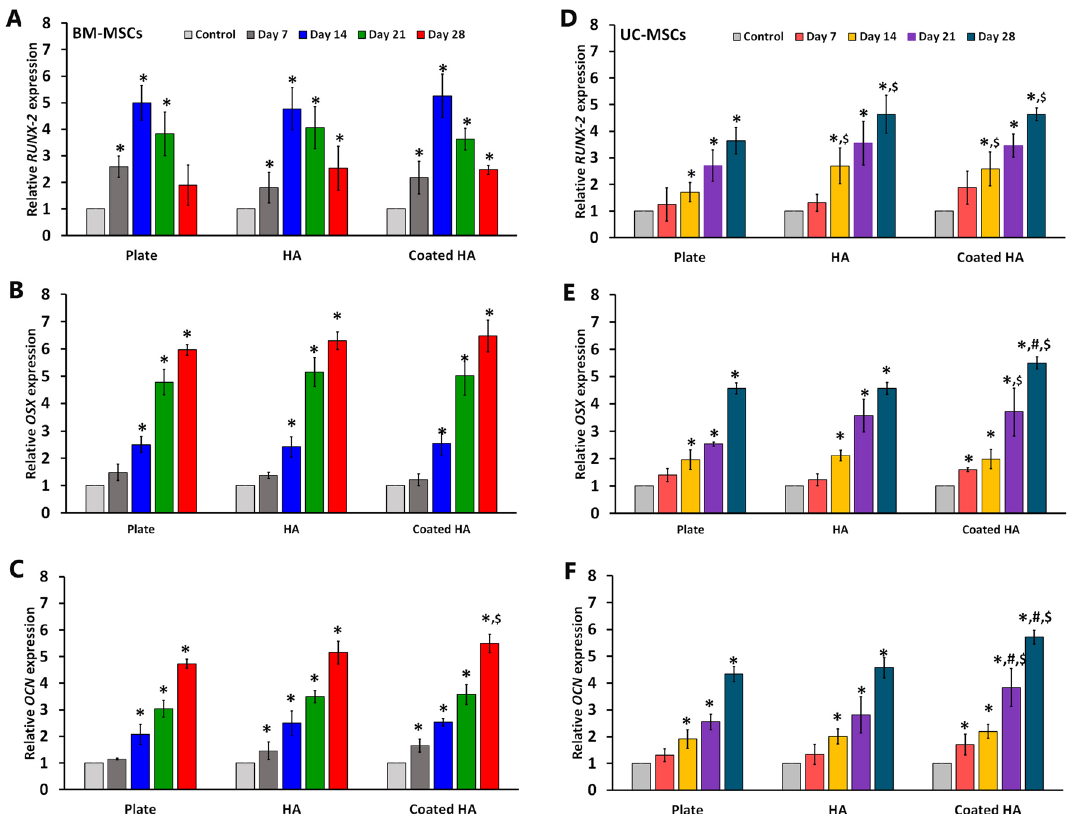
Figure 8. Real-time RT-PCR illustrates the expressions of osteogenic markers, RUNX-2 , osterix ( OSX ), and osteocalcin ( OCN ) in BM-MSCs ( A , B , C ) and UC-MSCs ( D , E , F ) during cultured on a plastic culture plate, the 3D-printed HA (HA) and coated 3D-printed HA (coated HA). MSCs cultured in complete DMEM medium at day 0 serve as the control. *Statistically significant data with P < 0.05 compared to control. N = 3, # P < 0.05 compared to MSCs cultured on 3D-printed HA at the same time point. $ P < 0.05 compared to MSCs cultured on a plastic culture plate at the same time